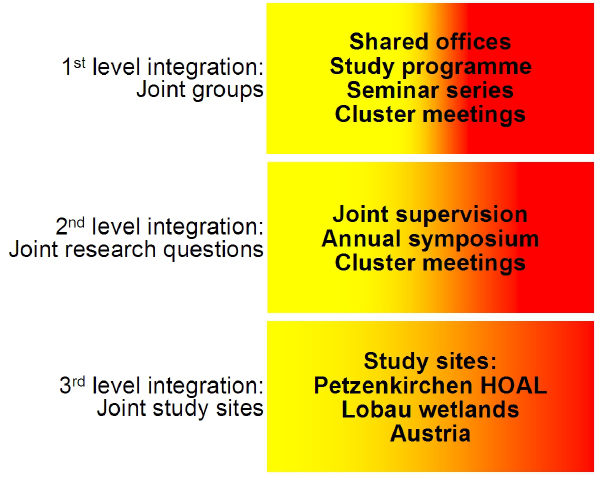
Fig. 1. Three levels of integration in the Vienna Doctoral Pro- gramme on Water Resource